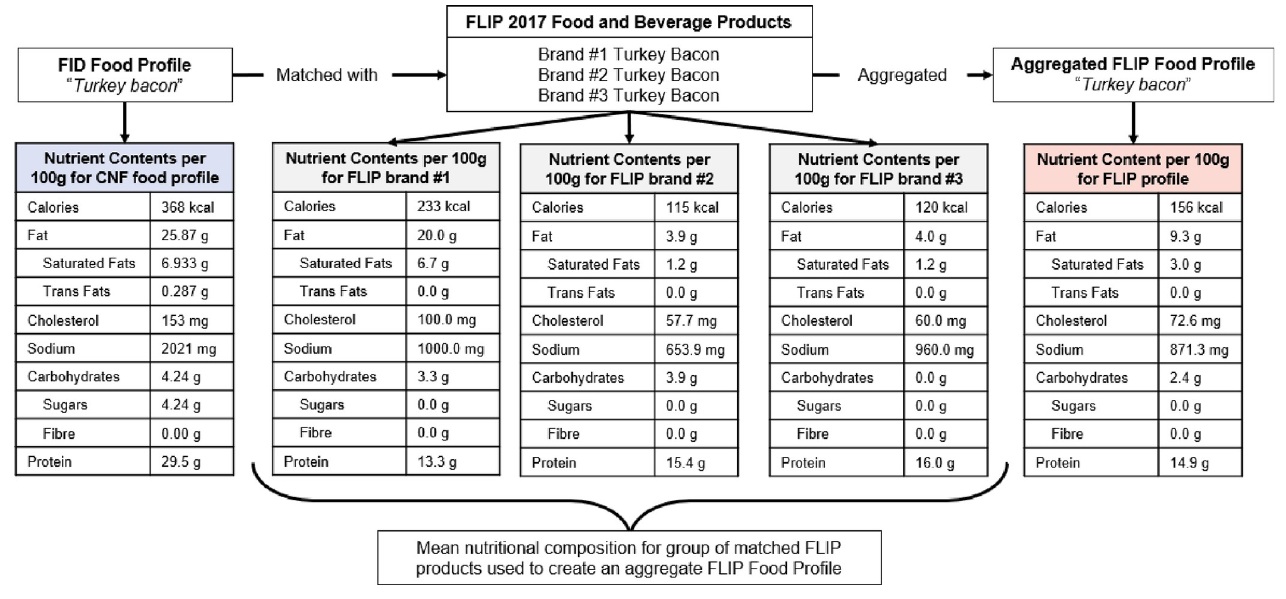
Fig 1. Creation of an aggregate nutritional composition (FLIP food profile) using the nutritional information for FLIP products matched to the same FID food profile. Abbreviations: FID = Food Ingredient Details; FLIP = Food Label Information Program database.